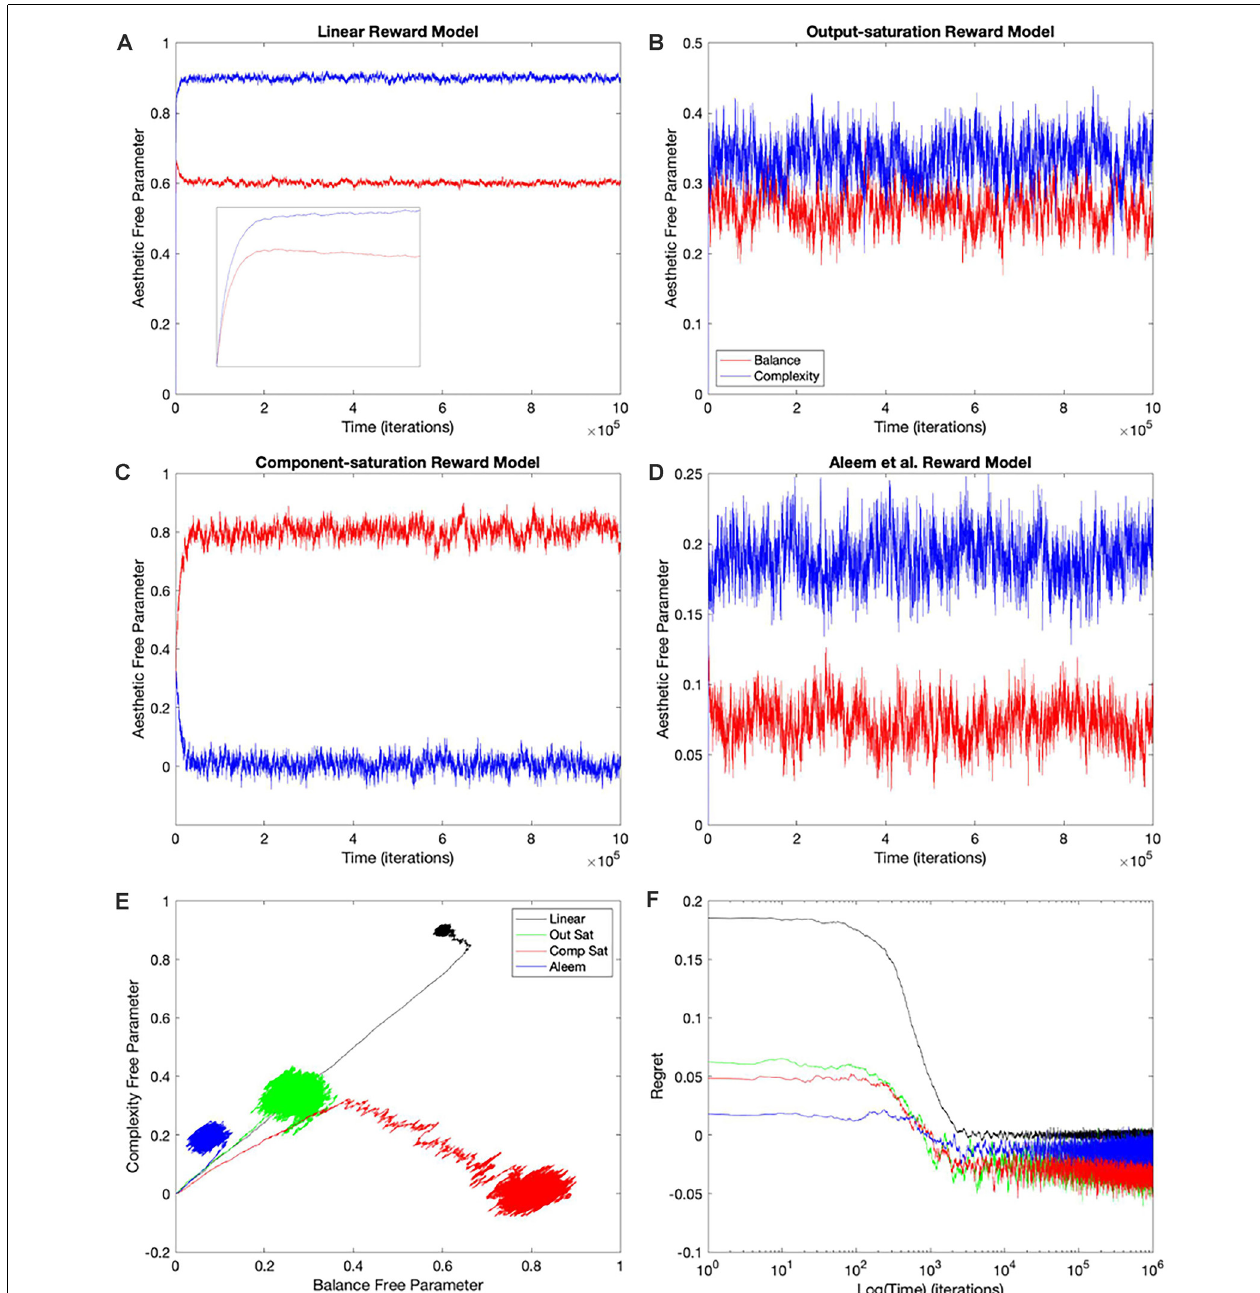
FIGURE 2 | Dynamics of the free parameters of the value function for the purely-linear conditions ( Table 1 ). (A–D) Linear, Output-saturation, Component-saturation, and Aleem et al.’s reward models respectively. Red and blue lines correspond respectively to free parameters related to balance and complexity in the sensory inputs. The inset in (A) provides details of the early dynamics (first 10,000 iterations). (E) Phase diagrams. (F) Time dependence of regrets, smoothed with a 500-iterations moving average. This figure indicates that linear value functions and update rules yield poor learning performance when the reward models are nonlinear. For example, regrets are significantly negative (overestimation of reward) for all nonlinear reward models (Panel F ).